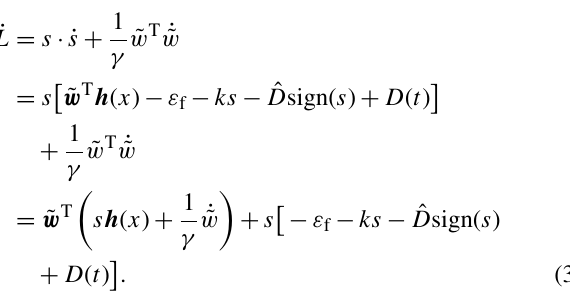
Figure 8. The effect of fuzzy logic control algorithm on reducing